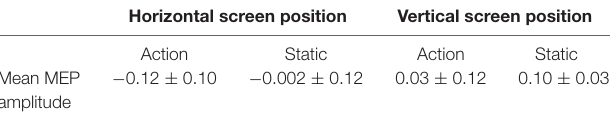
TABLE 1 | Mean motor evoked potential (MEP) amplitudes displayed as z -scores, for the action and static conditions on the vertical screen position for the right first dorsal interosseous (FDI) muscle.